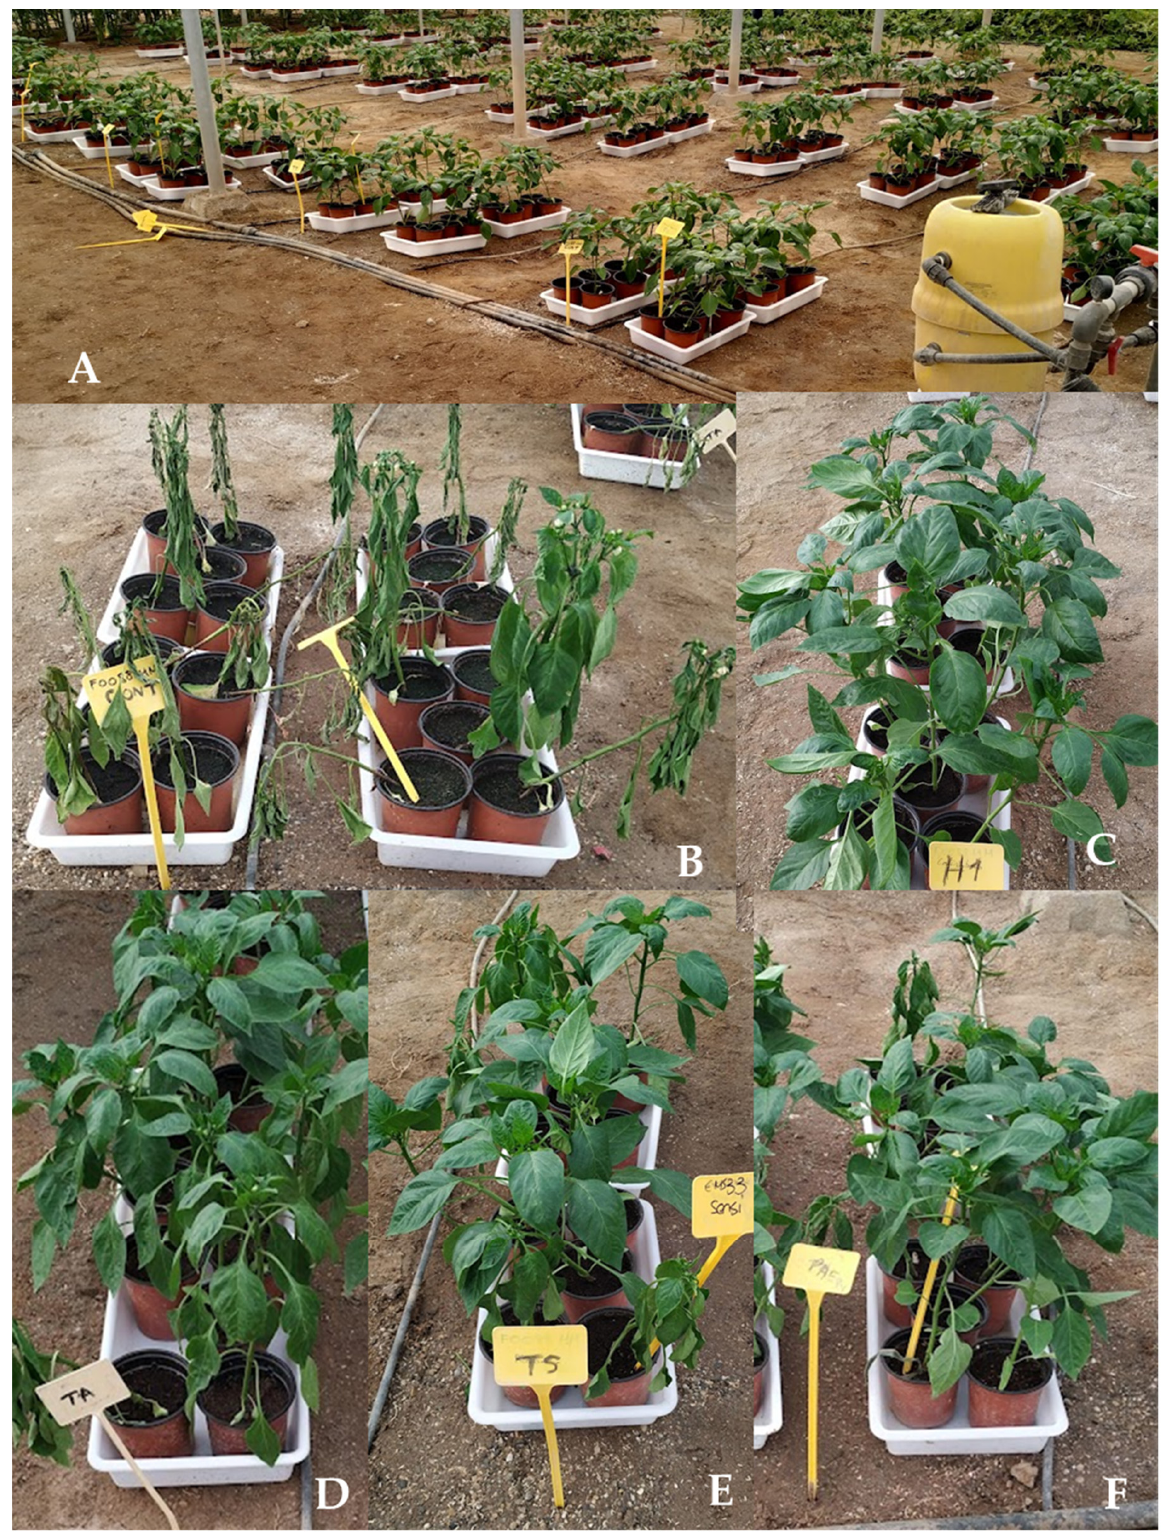
Figure 5. Effectiveness of BCAs in controlling disease caused by Phytophthora at end of assay (60 DATs): ( A ) distribution of plants in the greenhouse; ( B ) state of controls plants and plants treated with ( C ) T. longibrachiatum (TL), ( D ) T. aggressivum f. europaeum (TA), ( E ) T. saturnisporum (TS), and ( F ) P. variotii (PAE). Table 3. Phytophthora parasitica and P. capsici disease severity in pepper inoculated with TA, TS, TL, or PAE (10 5 spores per plant) in two experiments in greenhouse conditions in which plants were inoculated with antagonist before the pathogen and before/after (reinoculated, R). All plants, except